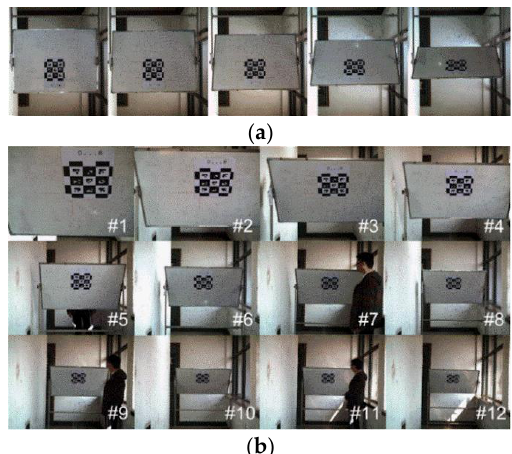
Figure 9. Position accuracy experiments with different configurations. ( a ) Different marker pitch. ( b ) Different marker depth. # 1 to 12 represents change in depth from 1963 to 7558 mm.